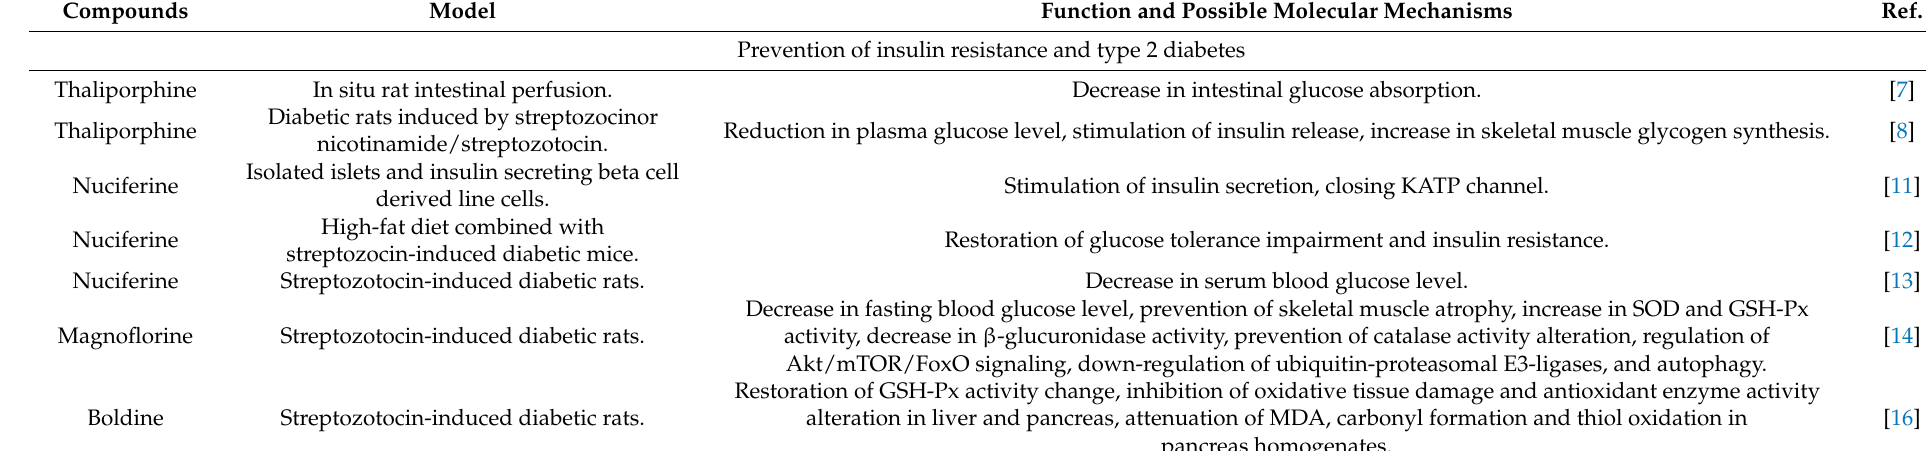
Table 1. The potential effect of natural aporphine alkaloids on metabolic syndrome-related disorders. Compounds